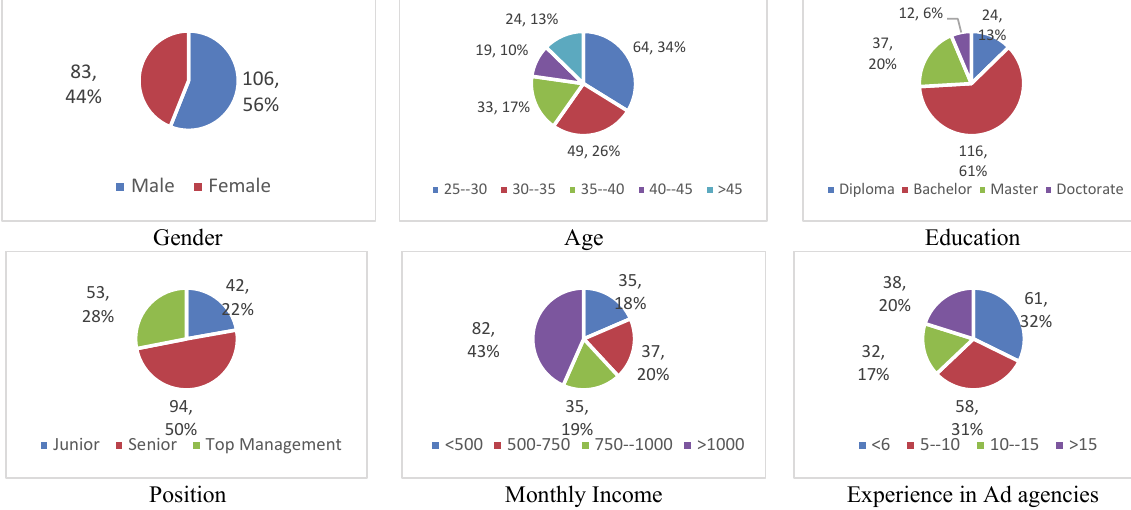
Fig. 2. Describing the sample's personal and demographic